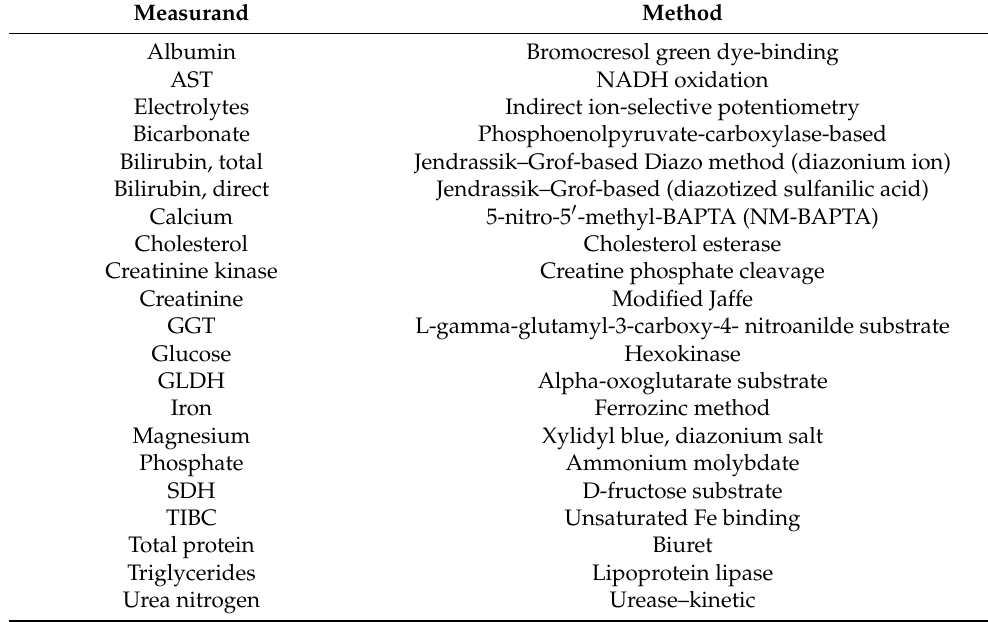
Table 1. Basic methodology for biochemical testing performed on the Roche